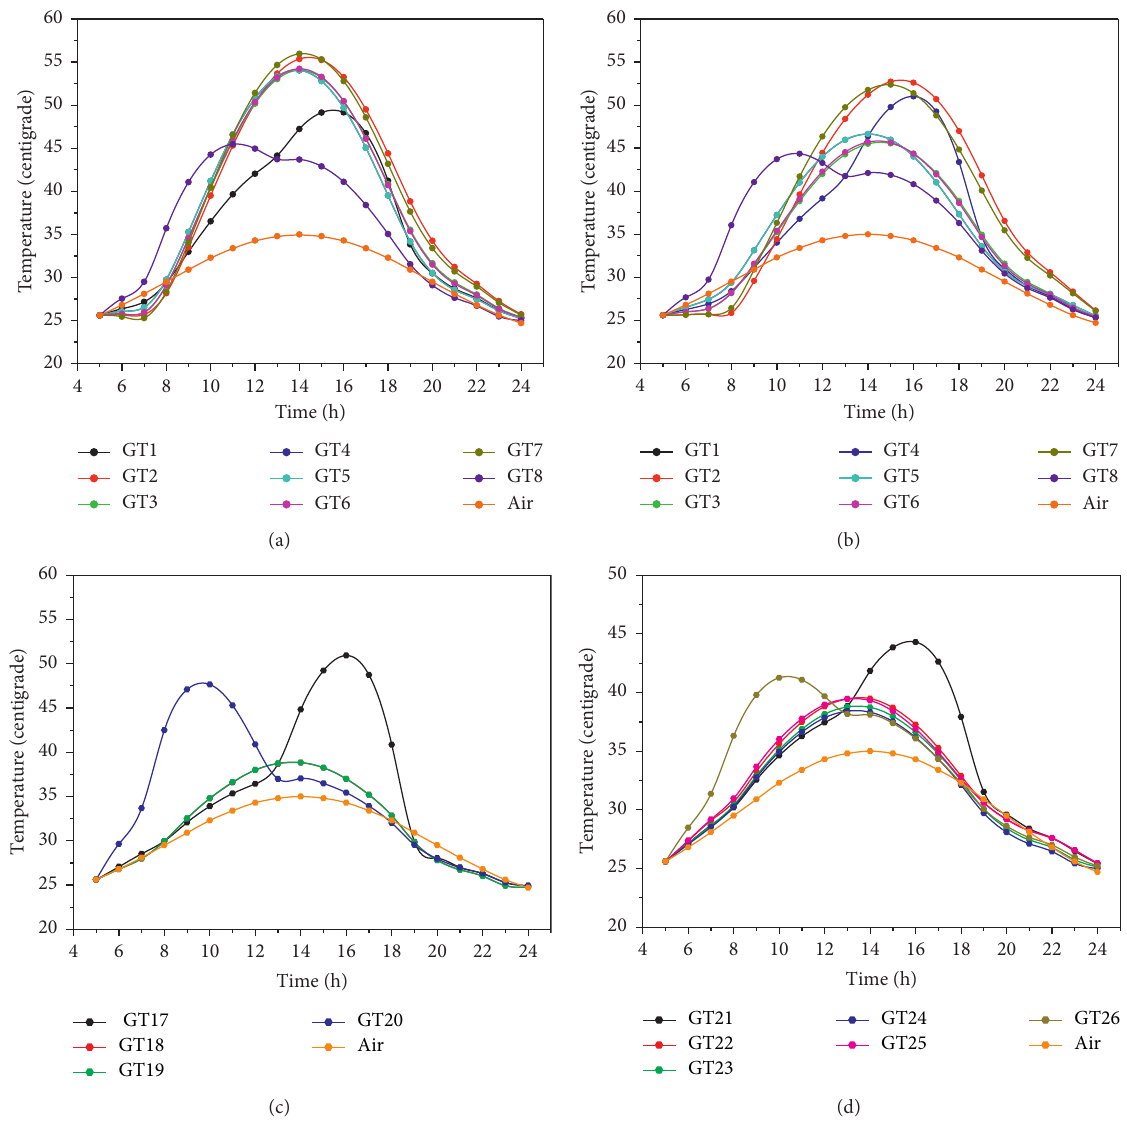
Figure 11: The temperature variations of the cross sections of the main girder.